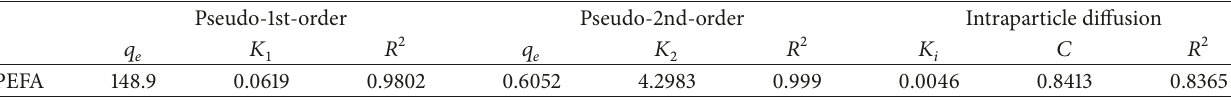
Table 4: Sorption kinetics parameters for Cd (II) ion adsorption by PEFA. Pseudo-1st-order